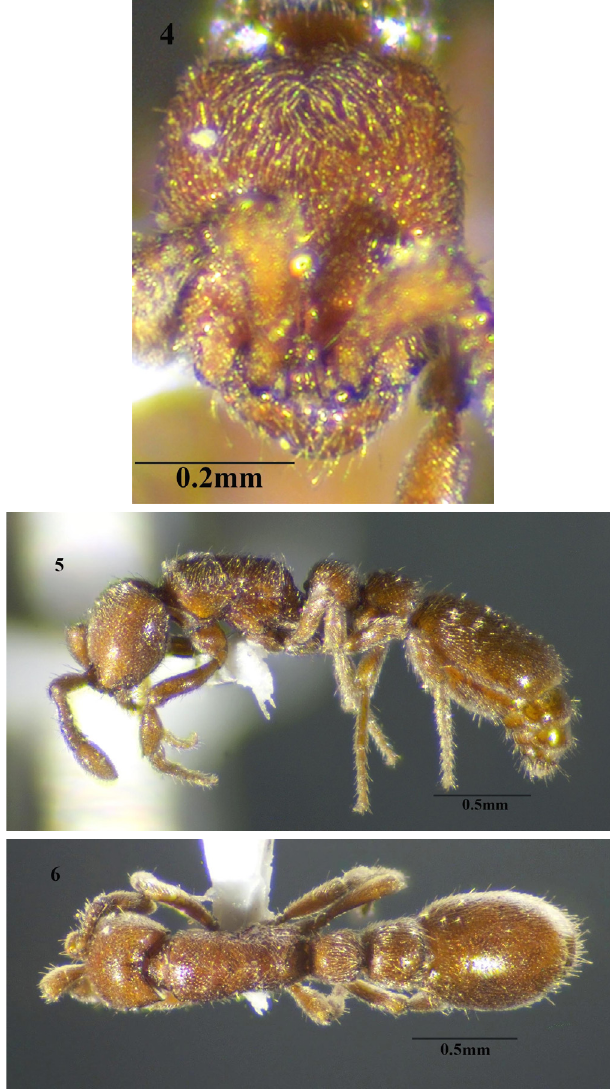
Figures 4-6 . Ooceraea biroi (Forel, 1907), (4) Head, frontal view; Habitus, (5) lateral view; (6) dorsal view.